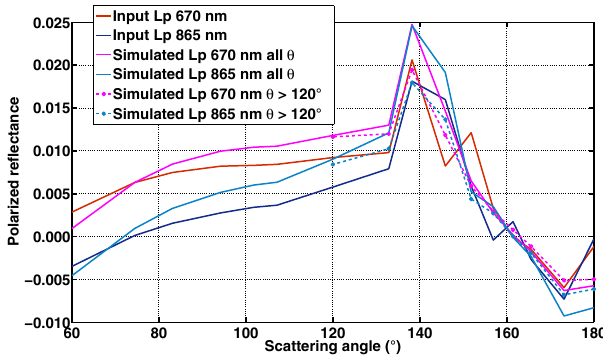
Figure 7. 3-D Polarized reflectances used as input for the aerosol above cloud algorithm (Waquet et al., 2013a) and polarized re- flectances simulated with the algorithm after the convergence of the retrieval. Reflectances at all angles were used (solid line) and reflectances with only scattering angles above 120 ◦ (dashed